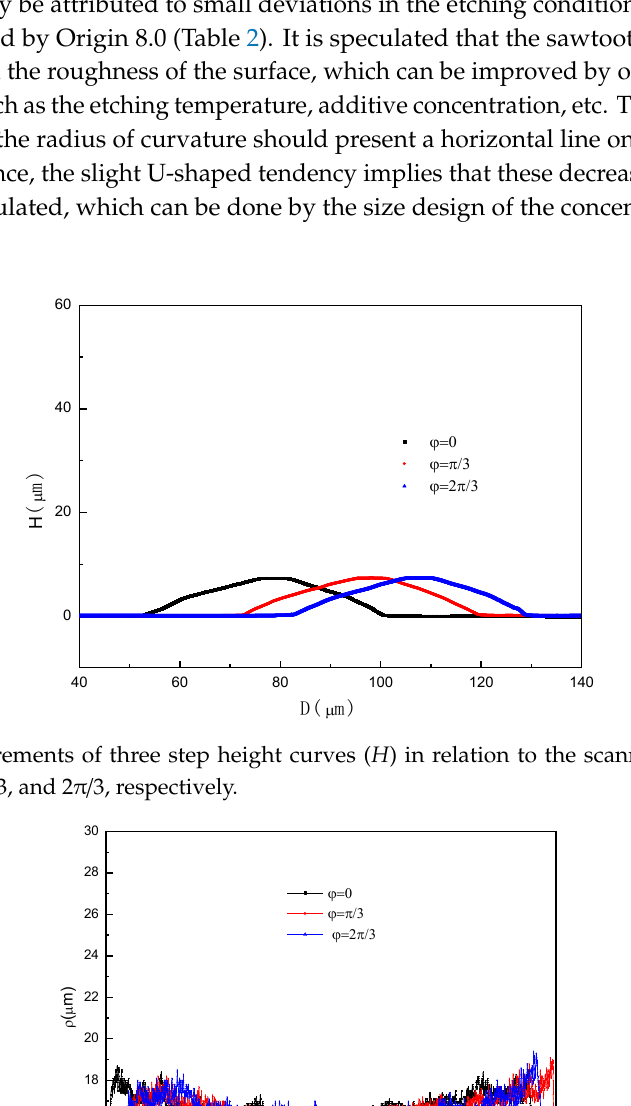
Figure 11. Measurements of three step height curves ( H ) in relation to the scanned path ( L ) with longitude  φ = 0, π  , and 2π  ,  respectively . 